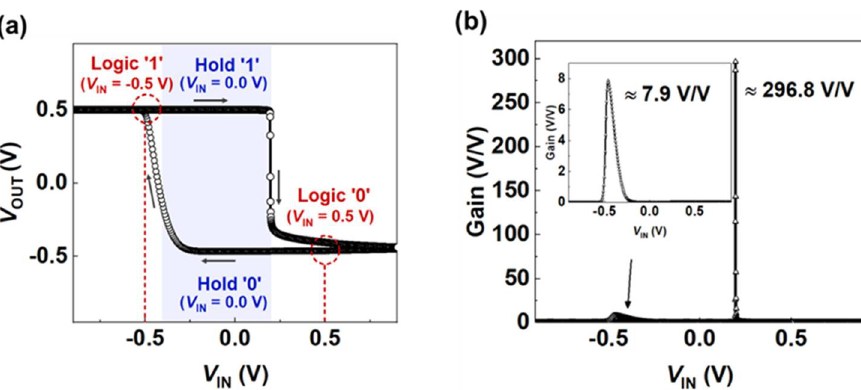
Figure 3. ( a ) Voltage transfer characteristics (VTCs) and ( b ) inverter gains of the LIM inverter under bias condition of V DD = 0.5 V and V SS = −1.3 V.